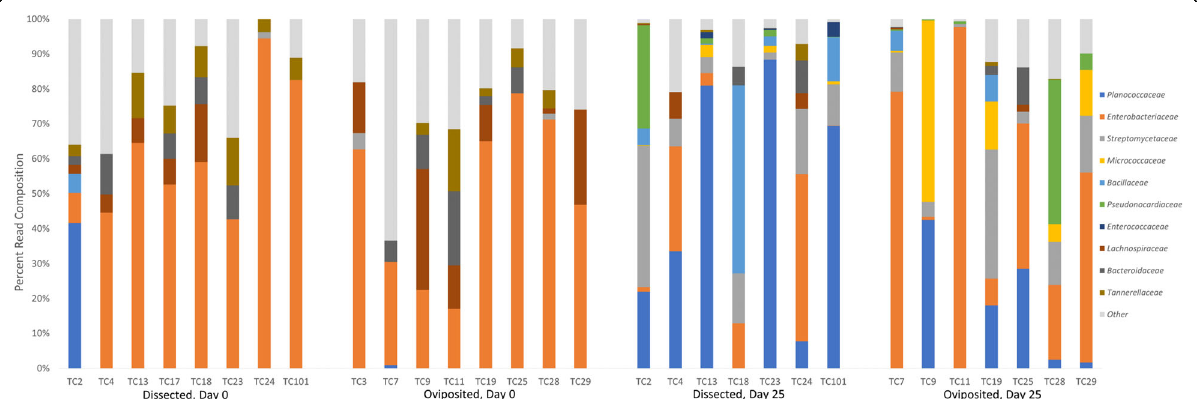
Fig. 5 Percent composition of bacterial families in eggshell communities from eggs that were either dissected from S. virgatus females or oviposited. Communities were sampled immediately after egg acquisition and on Day 25 of incubation in soil slurry. Each vertical bar represents a different eggshell; labels are identification numbers for the female which provided the egg. Colored portions of the bars represent the relative abundance of the top ten most abundant taxa; the remaining taxa were combined into the “ other ” category. The y-axis indicates the percent composition of total reads for that sample